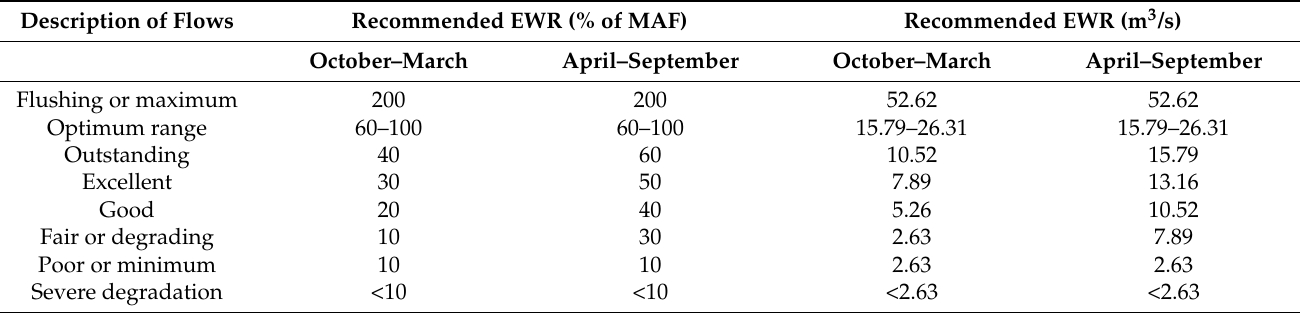
Table 2. Determination of the EWR of the Kor River according to the Tennant method.